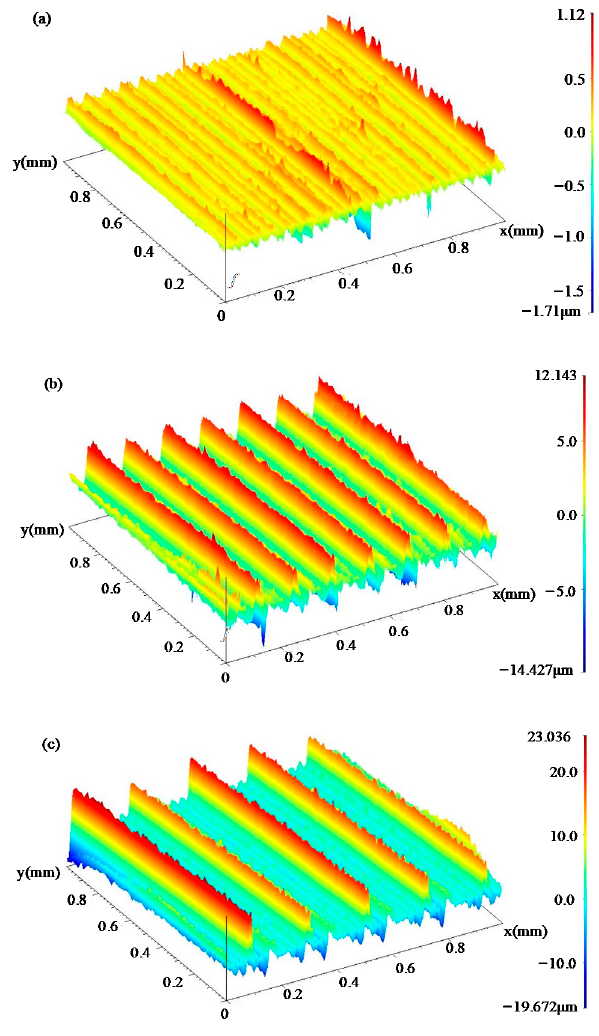
Figure 3. Surface topography of the specimens with different processing parameter: ( a ) Group 1, ( b ) Group 2 and ( c ) Group 3. Table 2. The processing parameter sets correspond to different target roughness.